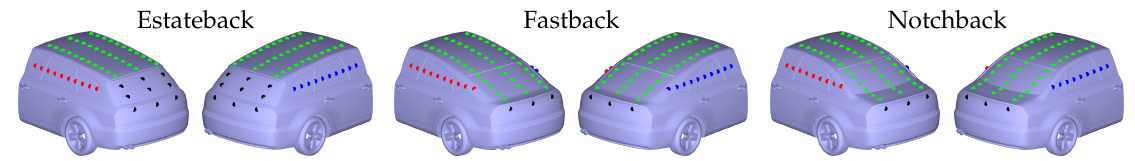
Figure 6. Pressure tapping locations and groupings on the DrivAer